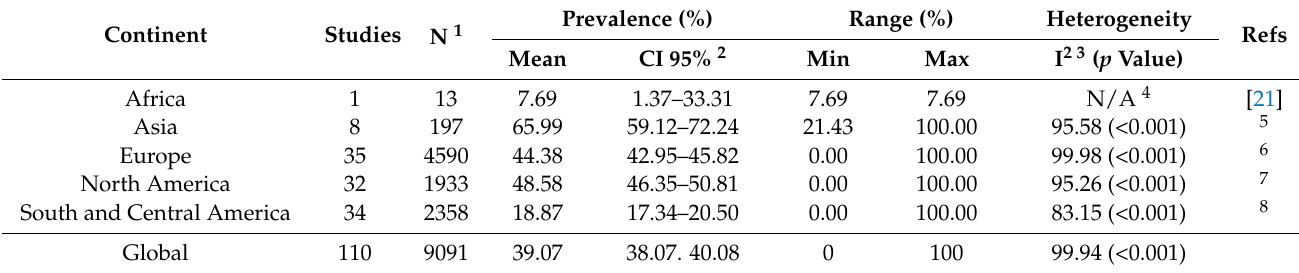
Table 3. Flock SRLV prevalence in each continent. Data extracted from scientific literature published from 1981 to 2020. Continent